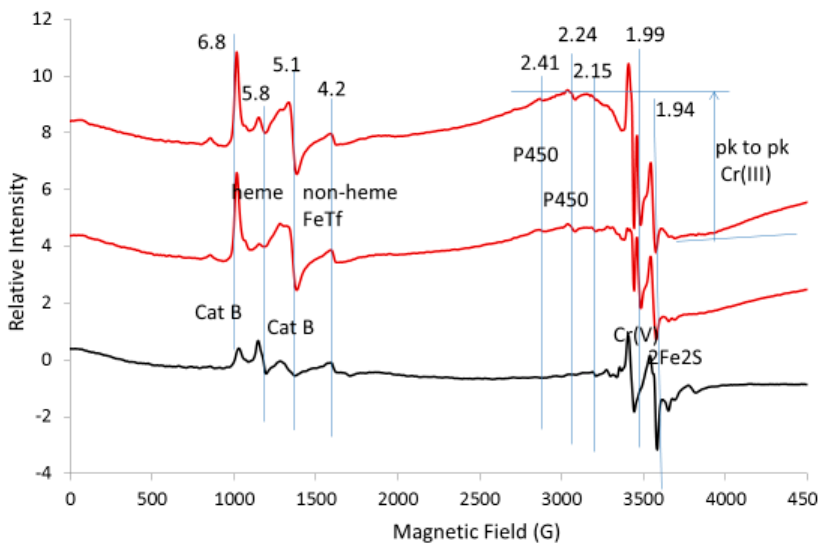
Figure 7. EPR spectra for control liver tissue (black) versus tissue treated with chromate (red). The vertical lines indicate the g-values for EPR lines from Complex I (primarily N1b) and Complex II (S1) as discussed in the text. Spectrometer conditions: microwave freq., 9.632 GHz; temp., 10 K, mod. amp., 5 G; microwave power, 20 mW; sweep time, 83.89 s; time constant, 81.82 ms.